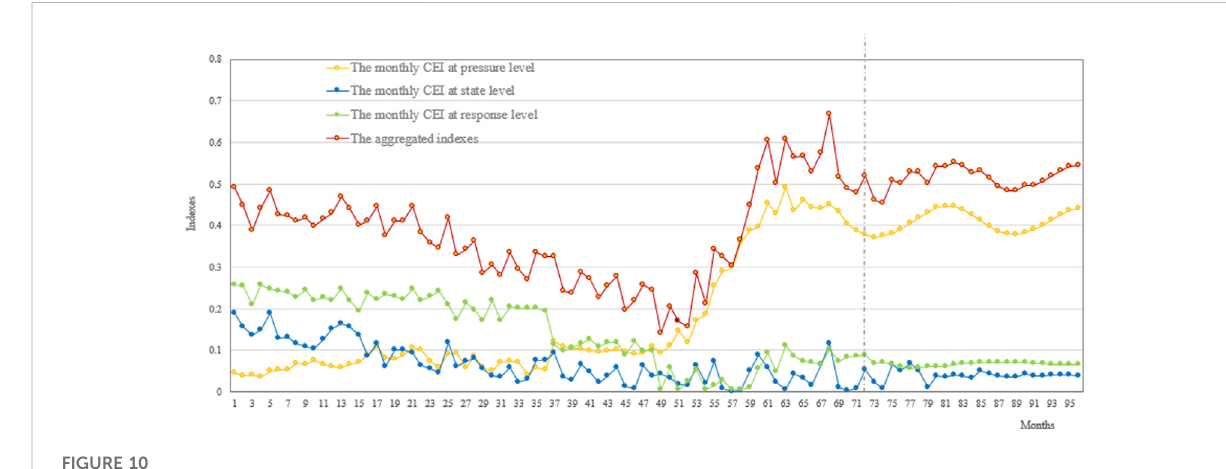
FIGURE 10 The monthly CEI and the aggregated indexes from 2014 to 2021 in the Changning shale gas play.